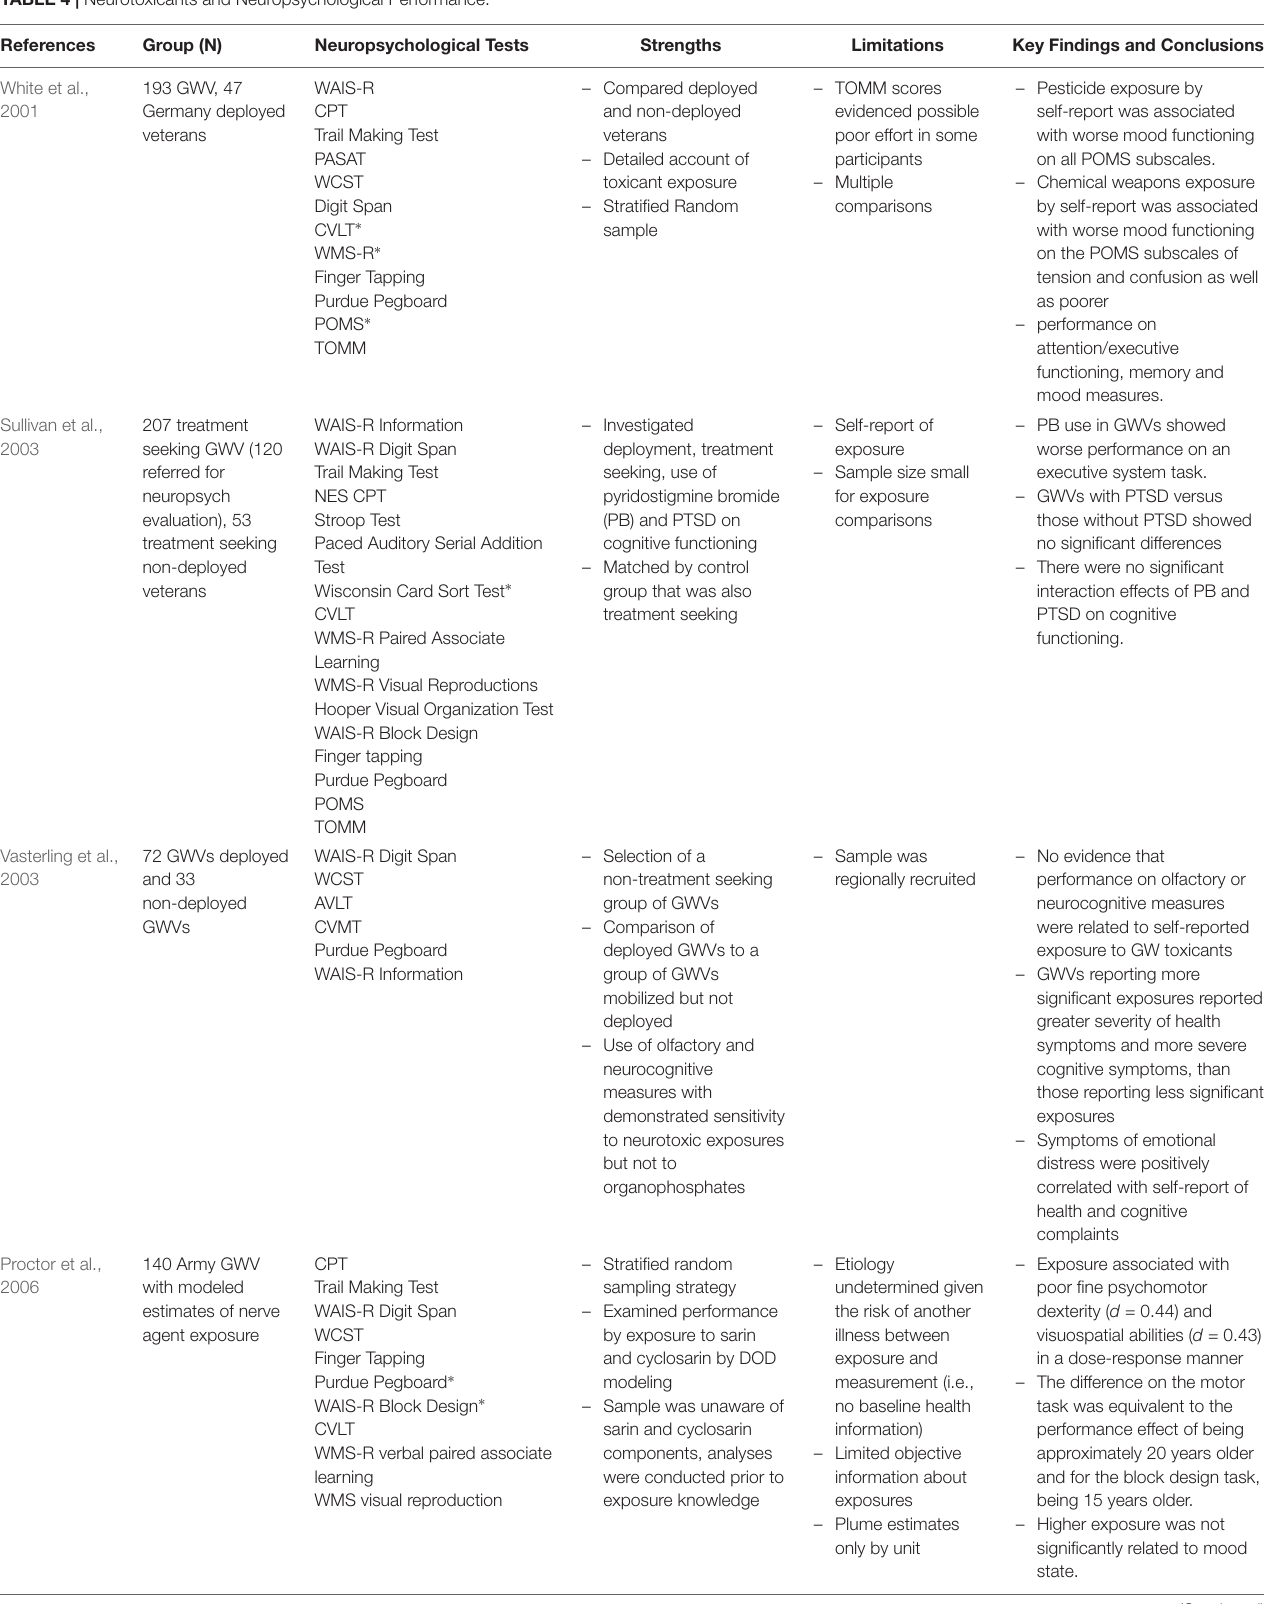
TABLE 4 | Neurotoxicants and Neuropsychological